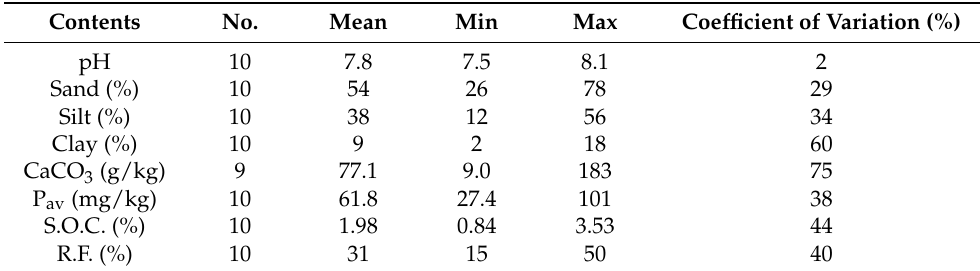
Table 1. Main statistics of the soil properties (0–50 cm).